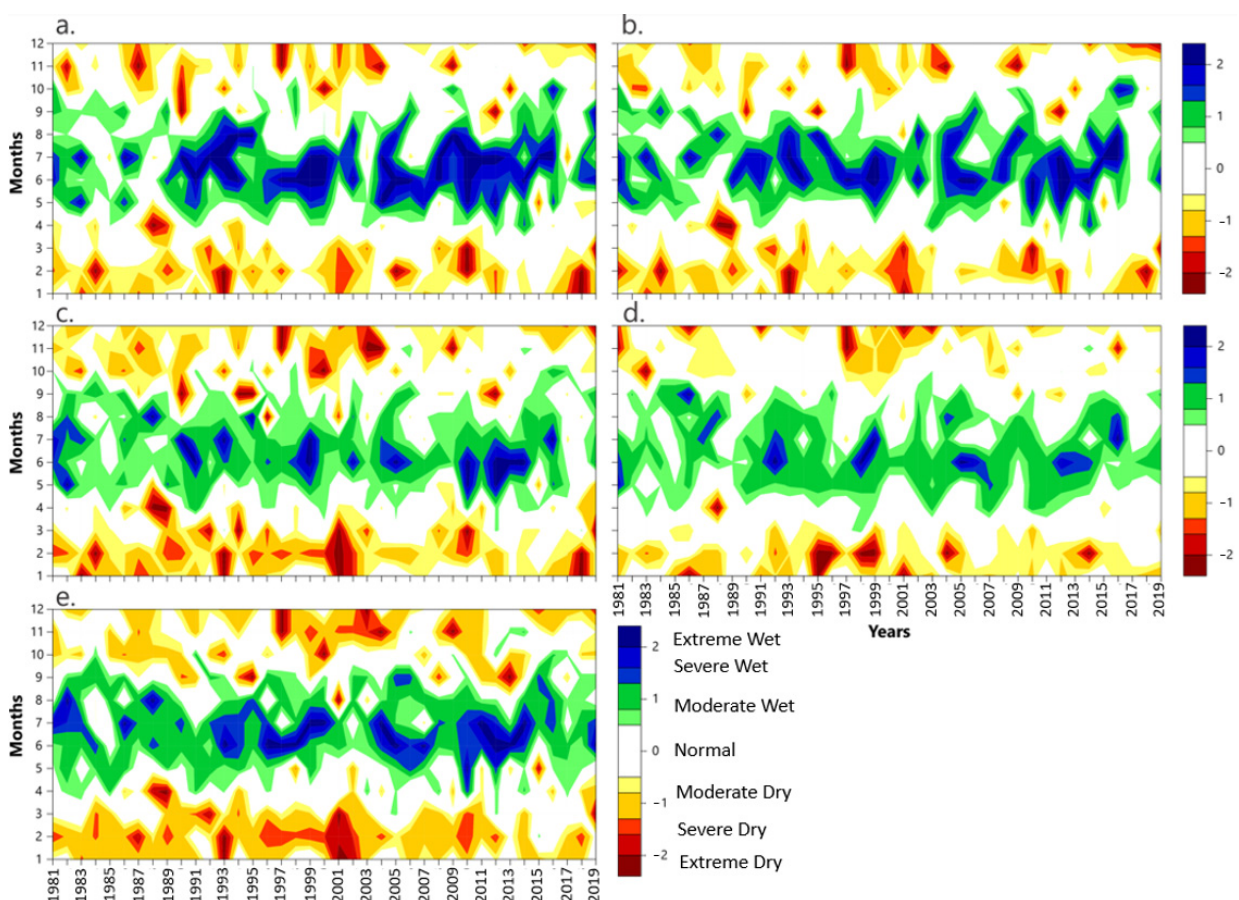
Figure 6. SPI derived from ERA5 data for the Mixed Ecoregion for Beechy ( a ), Coronach ( b ), Rock Point ( c ), Swift Current ( d ), and Taber ( e ) in the period 1981–2019.